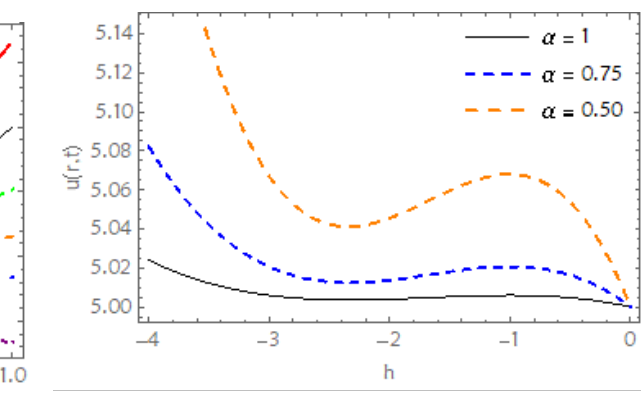
Fig. 3: Plot of solution u ( r , t ) Vs. t when n = 1 = α = r for Ex. 4.1